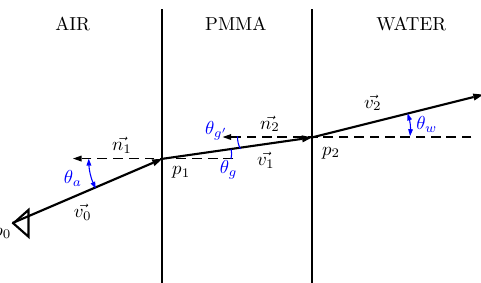
Figure 13. Ray tracing schematic of a single optical ray passing through air, PMMA and